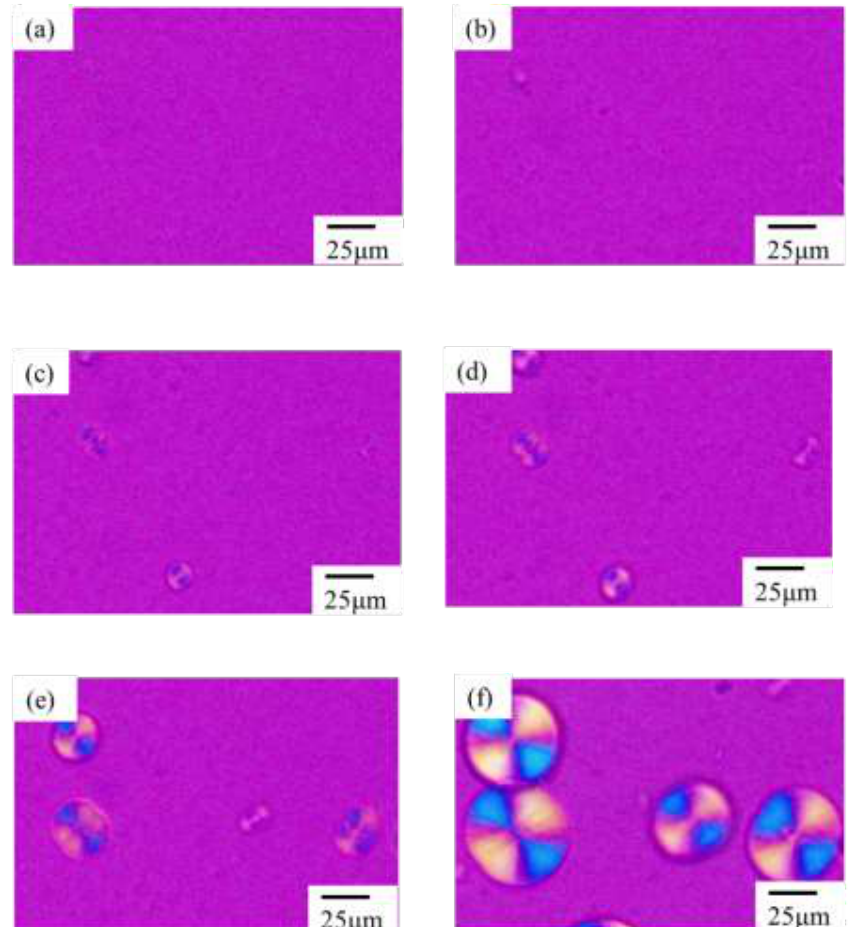
Figure 3. Morphology development of α -spherulite of neat PVDF during isothermal crystallization at 165 °C: ( a ) 8 min, ( b ) 10 min, ( c ) 13 min, ( d ) 15 min, ( e ) 20 min, and ( f ) 30 min.